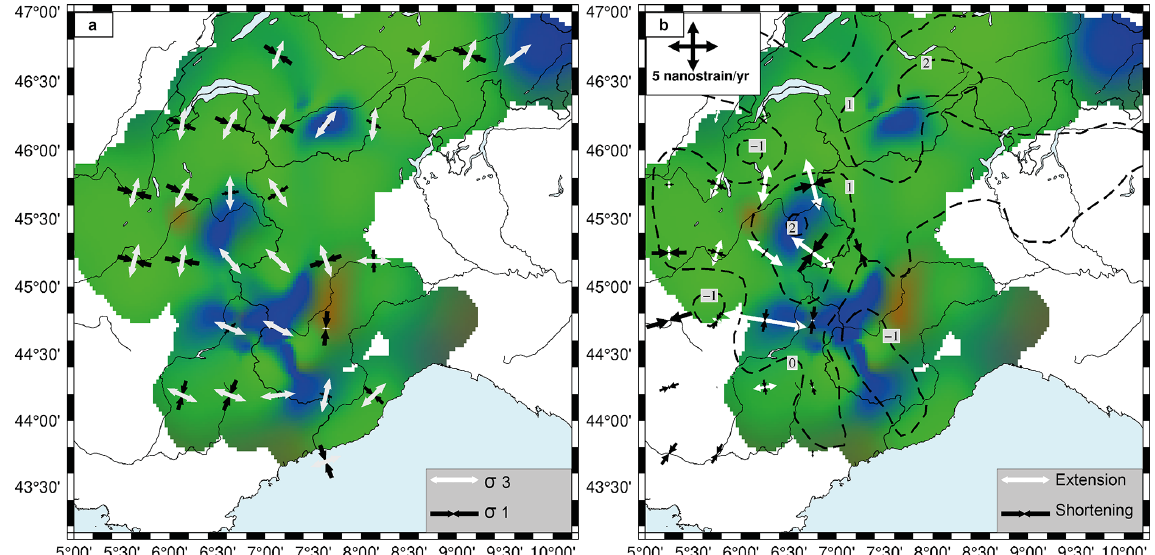
Figure 11. (a) Stress field from MSATSI inversion from Fig. 6. (b) Global Navigation Satellite System (GNSS) strain rates from Walpers- dorf et al. (2018) showing extension (white arrows) and compression (black arrows). Dashed lines represent contours of vertical velocities (in mmyr − 1 ) from Sternai et al. (2019). In the background of both graphs is the Bayesian interpolation of deformation style from focal mechanisms from Fig. 7.